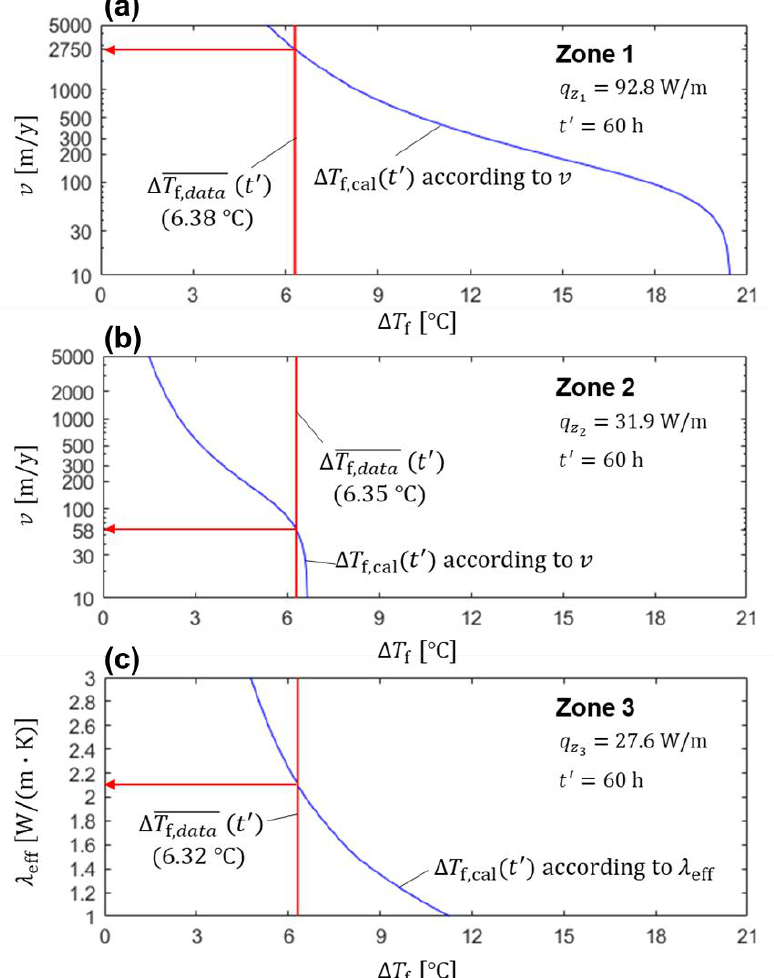
Figure 10. Temperature increment according to the heat exchanger rate and the groundwater velocity at the end of the TRT; ( a ) Zone 1, ( b ) Zone 2 and ( c ) Zone 3.